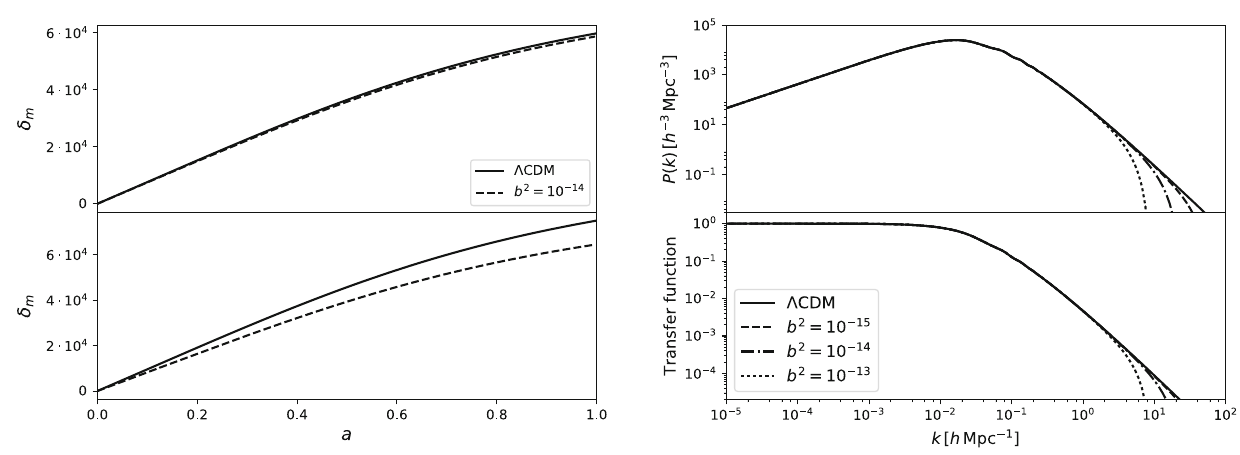
Fig. 3 Top left panel: total matter overdensity for b = 10 − 14 at scale k = 2 hMpc − 1 . Maximum difference between WDM and CDM case is ∼ 5%), bottom left panel represents the case for k = 5 hMpc − 1 , where difference to the CDM case is ∼ 20%. Top right panel: linear matter